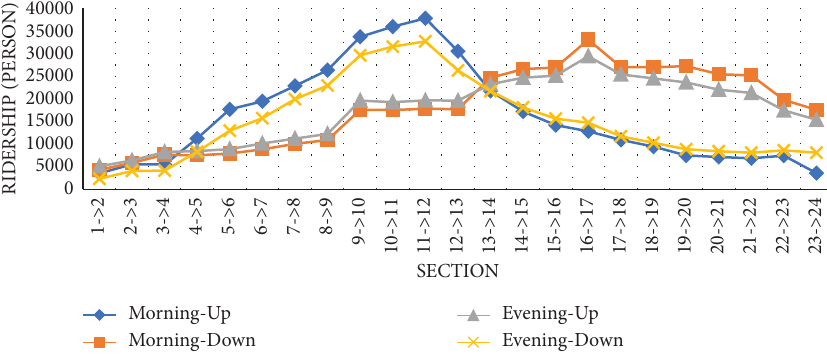
Figure 6: Cross-sectional ridership during the morning and evening peaks. Table 2: Basic parameters of AWGA.